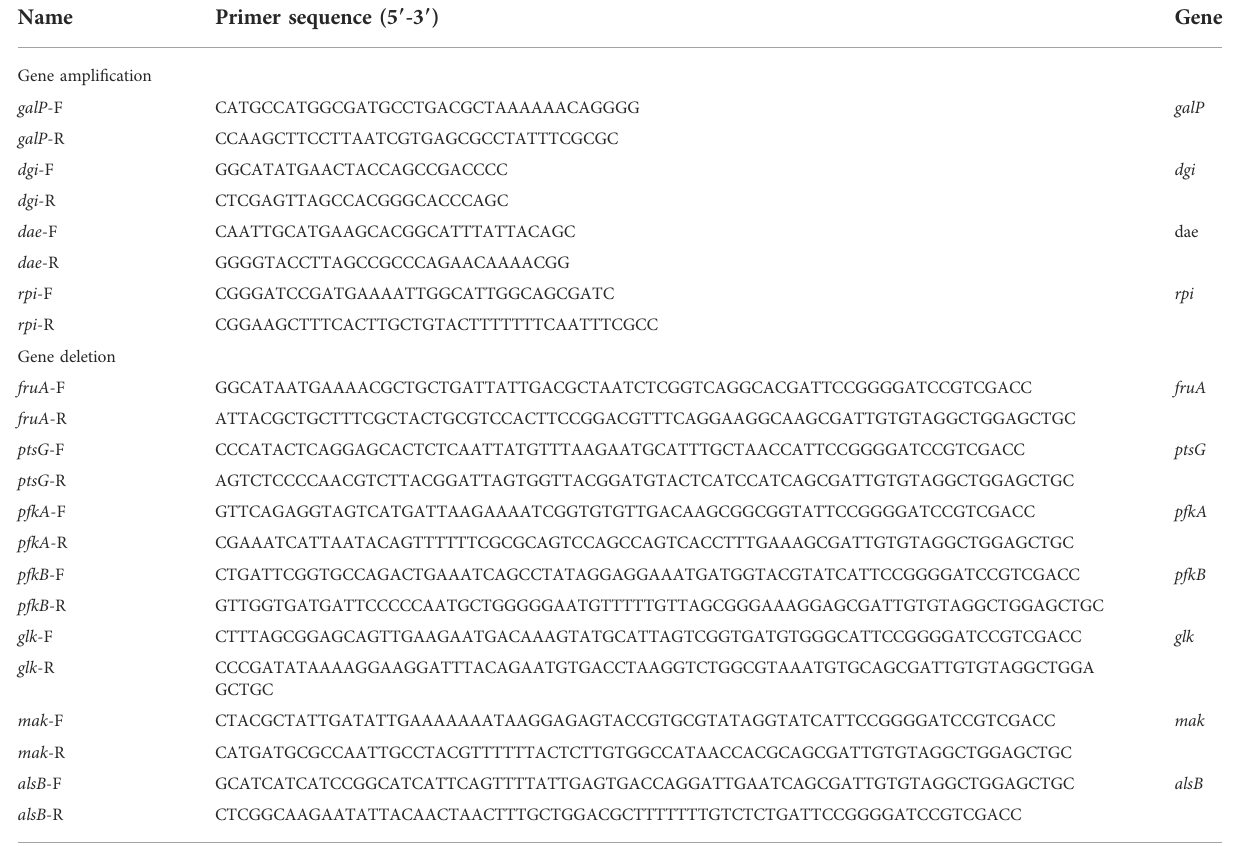
TABLE 2 Primers applied in gene ampli fi cation and